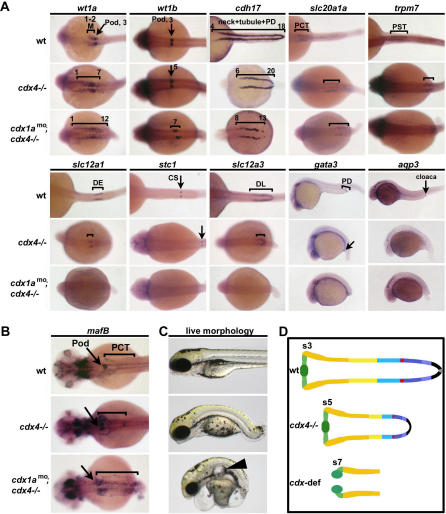

cdx Genes Position the Pronephros along the Embryonic Axis and Are Requisite for Distal Segment FormationExpression of segment markers was performed on wild-type, cdx4–/– mutants, and cdx-deficient embryos at (A) 26 hpf and (B) 48 hpf using whole-mount in situ hybridization. Brackets and arrows indicate expression domains in each embryo. Numbers indicate somite number. Dorsal views of embryos, with anterior to the left, with the exception of lateral views for gata3 and aqp3 expression. (C) Live wild-type, cdx4–/– mutants, and cdx-deficient embryos at 72 hpf. Arrowhead indicates glomerular cyst in the cdx-deficient embryo. Lateral views are shown, with anterior to the left. (D) Summary of nephron segmentation in cdx4–/– mutants and cdx-deficient embryos as compared to wild-type at 48 hpf. Numbers indicate anterior somite boundary of each pronephros.